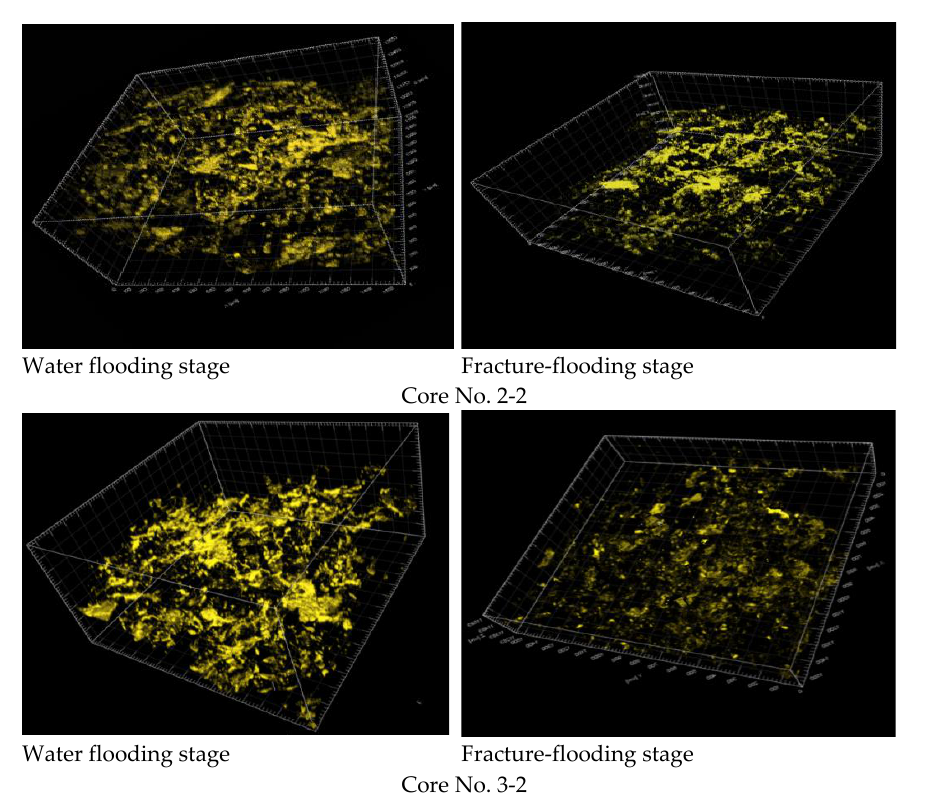
Figure 11. Three-dimensional distribution map of the remaining oil in cores at different displacement stages using confocal scanning laser .